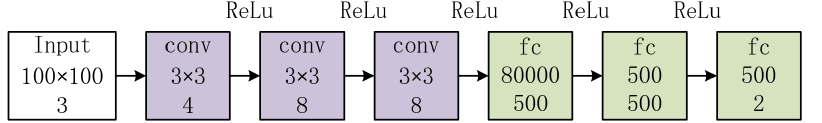
Figure 11. Structure of a CNN network used to ensure data coherence.